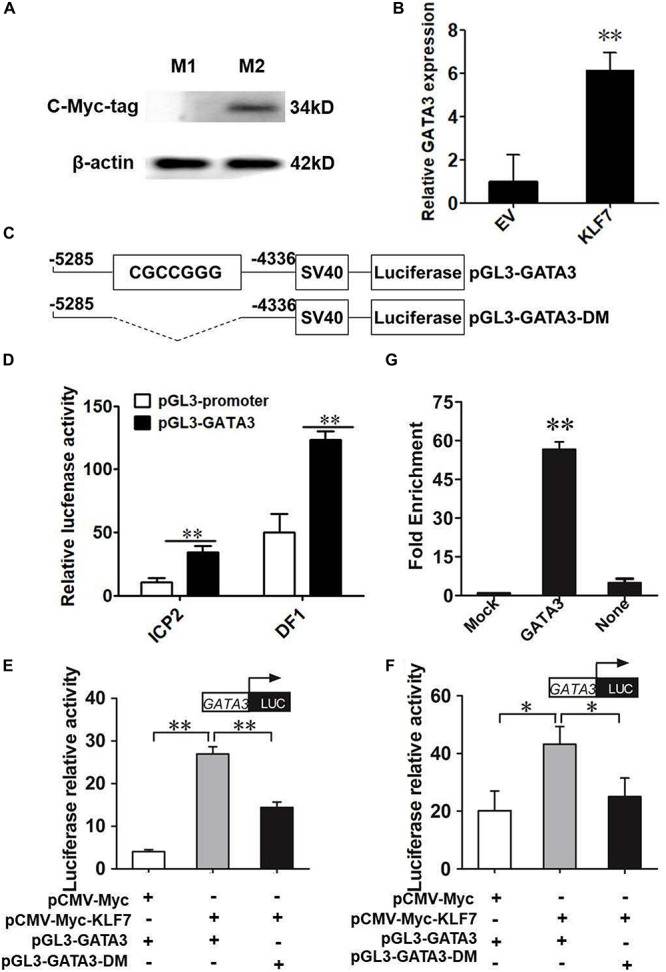
KLF7 directly regulates GATA3 transcription. (A) Western blot identification of KLF7 expression vector pCMV-Myc-KLF7. M1, the cell lysates from the immortalized chicken preadipocyte cell line (ICP2) transfected with pCMV-Myc vector; M2, the cell lysates from the preadipocytes transfected with pCMV-Myc-KLF7. The western blot analysis was repeated in three independent experiments. (B) The effect of KLF7 overexpression on the endogenous gene expression of GATA3 in ICP2 cells. ICP2 cells were transfected with either pCMV-Myc-KLF7 (KLF7) or pCMV-Myc (EV). Forty-eight hours after transfection, total RNA was isolated and the mRNA expression levels of GATA3 were measured using qRT-PCR. TBP was used as an internal control. Values represent mean ± SD from three independent experiments with three replicates in each. Asterisks indicate significant difference (Student’s t-test), P < 0.01(∗∗). (C) Schematic diagram of GATA3 reporter constructs. A ∼950-bp genomic DNA fragment spanning −5285 to −4336 bp upstream of the translation initiation codon ATG of GATA3 was amplified by PCR and cloned into pGL3-Promoter vector. In the pGL3-GATA3-DM construct, the CGCCGGG core sequence is deleted and shown as a dashed line. (D) Reporter gene analysis of the upstream region (−5285/−4336) of GATA3 gene in ICP2 and DF-1 cells. The cells were transfected with either pGL3-GATA3 or pGL3-Promoter (empty vector), and pRL-TK Renilla luciferase vector (100:1). After 48 h of cotransfection, relative luciferase activity was measured. The relative activity was expressed as the ratio of firefly to Renilla luciferase activity. Values represent mean ± SD from three independent experiments with three replicates in each. Asterisks indicate significant difference (Student’s t-test), P < 0.01(∗∗). (E,F) The effect of KLF7 overexpression on the reporter activity of the wild-type reporter pGL3-GATA3 and mutation reporter pGL3-GATA3-DM in ICP2 (E) and DF-1 cells (F). The cells were cotransfected with pGL3-GATA3 or pGL3-GATA3-DM and pCMV-Myc-KLF7 (KLF7) or pCMV-Myc (EV), and pRL-TK Renilla luciferase vector (50:50:1). After 48 h of cotransfection, relative luciferase activity was measured. The relative activity was expressed as the ratio of firefly to renilla luciferase activity. Values represent mean ± SD from three independent experiments with three replicates in each. Asterisks indicate significant difference (student’s t-test) P < 0.01 (∗∗), P < 0.05 (∗). (G) ChIP assay for KLF7 binding to the GATA3 upstream region (−4561/−4439). ChIP assays were performed using the c-Myc tag antibody and purified mouse IgG, which was used as a negative control (Mock). Immunoprecipitated DNA samples were purified and analyzed by qPCR using two specific pairs of primers. One pair of primers for the GATA3 upstream region (−4561/−4439), and the other pair of primers for the coding genomic region (+39/+149) of GATA3, which was used as a negative control (None). Non-immunoprecipitated DNA (1%) was used as input control. Data were presented as fold enrichment over the input control. Values represent mean ± SD from three independent experiments with three replicates in each. Asterisks indicate significant difference (student’s t-test), P < 0.01 (∗∗).